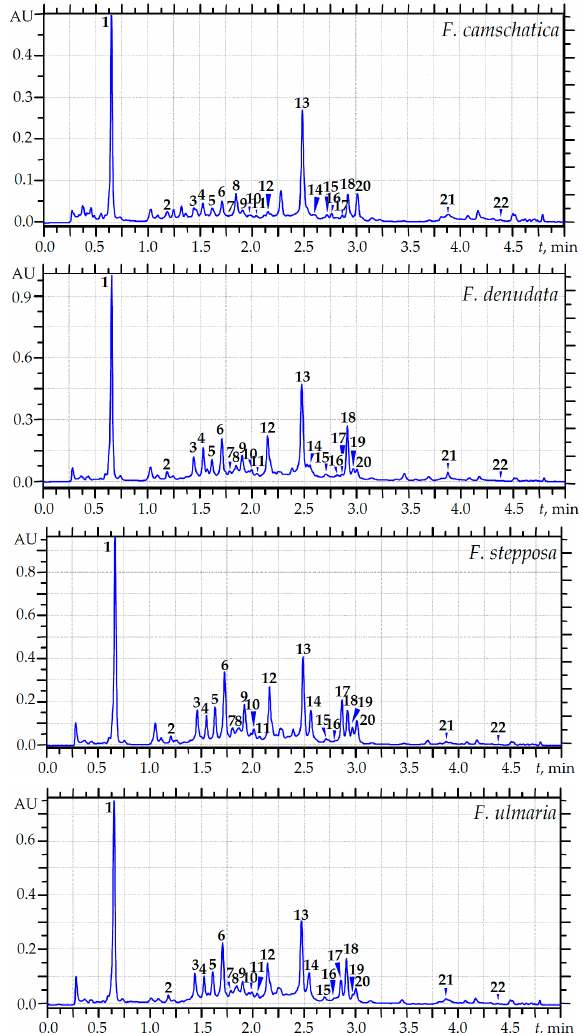
Figure 1. MC-RP-HPLC-UV chromatograms of four meadowsweet floral tea decoctions at 270 nm. Figure